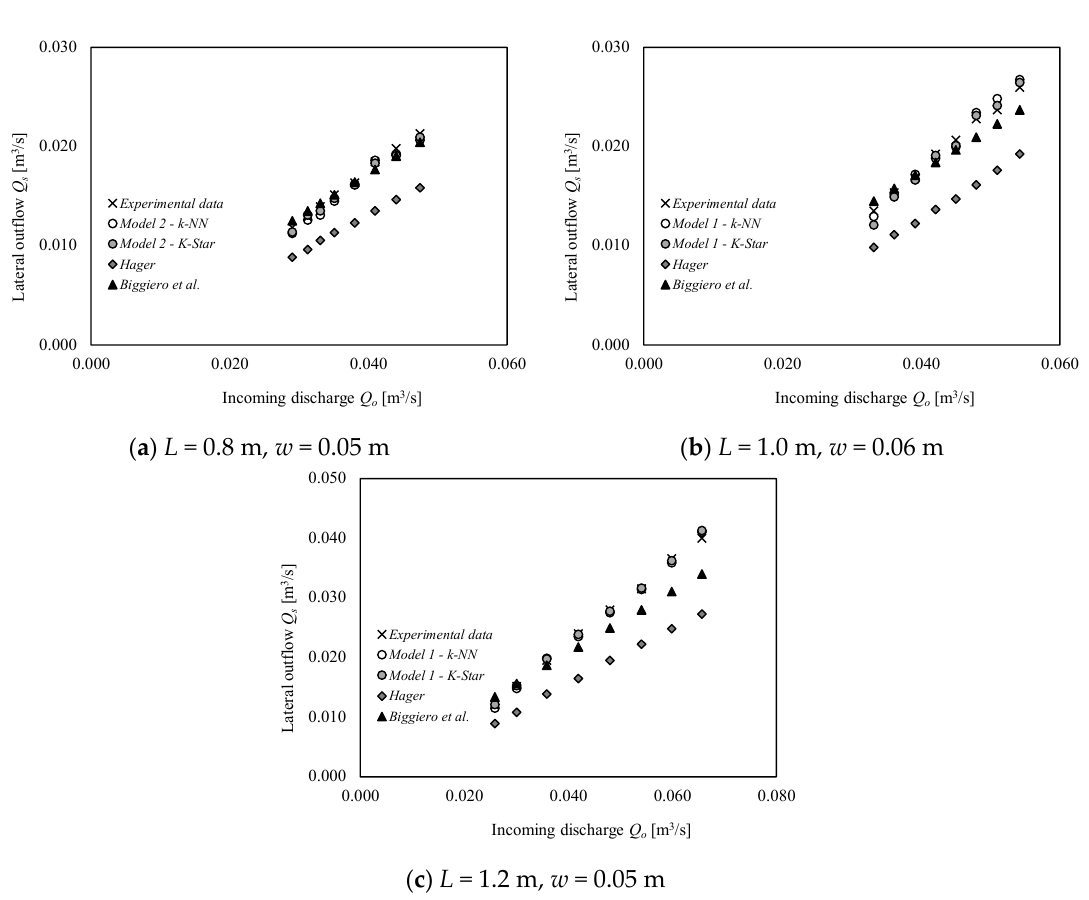
Figure 15. Lateral outflow versus incoming discharge: comparison among results provided by lazy machine learning algorithms, other models and experimental results.